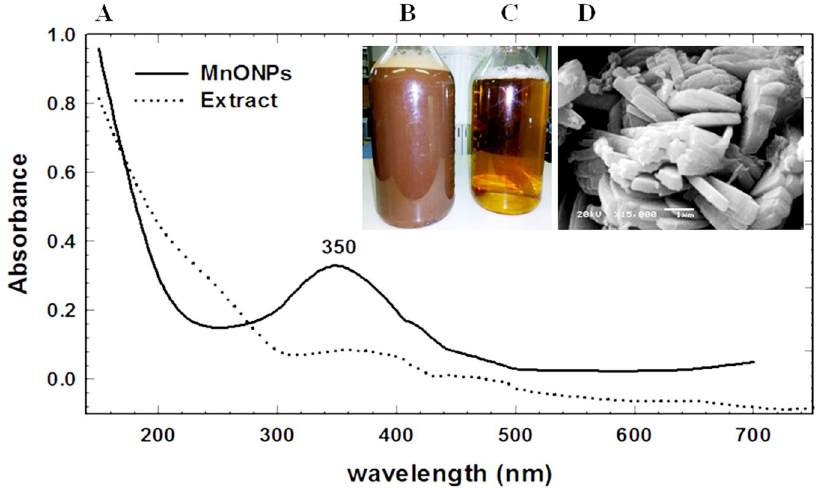
Figure 2. ( A ) UV–Vis spectra of fungus-fabricated MnO NPs shown surface plasmon resonance peak at 350 nm, ( B ) The final fabricated MnO NPs, ( C ) The extract of endophytic Trichoderma virens strain EG92, and ( D ) SEM image of fungus-fabricated MnO NPs shows its rod-shape